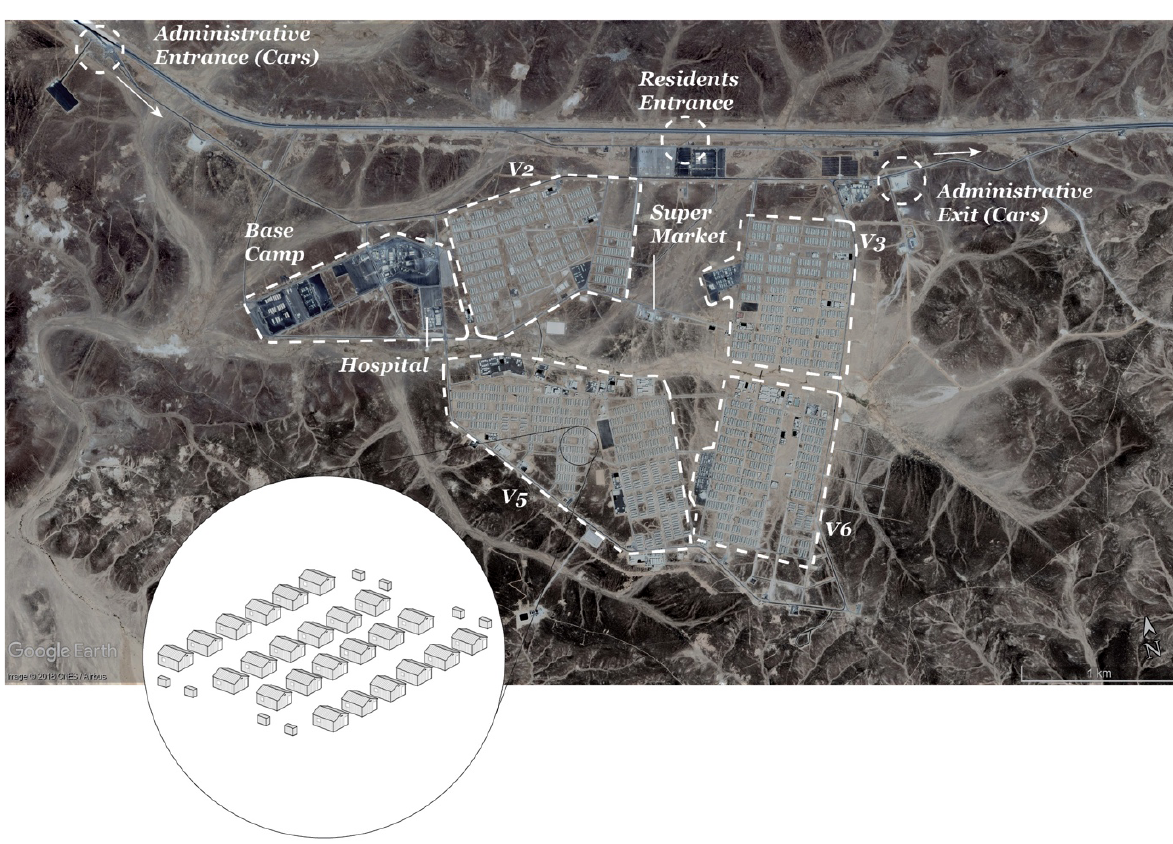
Figure 3. The master plan and shelter typology of Azraq camp. Source: Dalal based on Google Earth, 2017. ing a recognition for a need for improved shelter